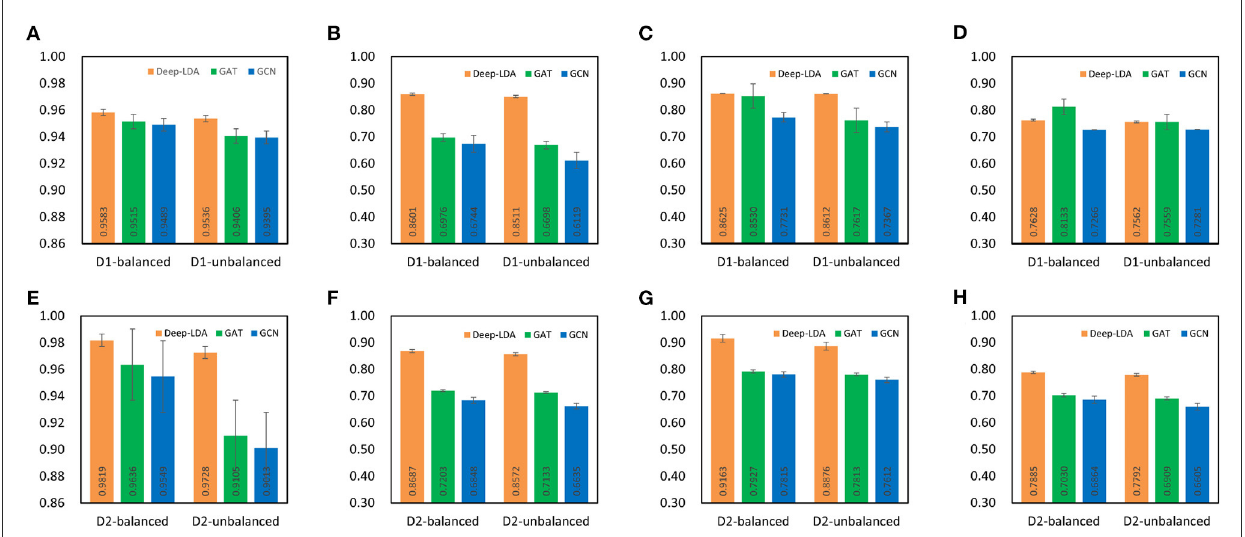
FIGURE4 Comparison of the effects of each module. D1 and D2 represent NoncoRNA and ncDR, respectively. (A) AUC on D1. (B) AUPR on D1. (C) F1-score on D1. (D) MCC on D1. (E) AUC on D2. (F) AUPR on D2. (G) F1-score on D2. (H) MCC on D2.